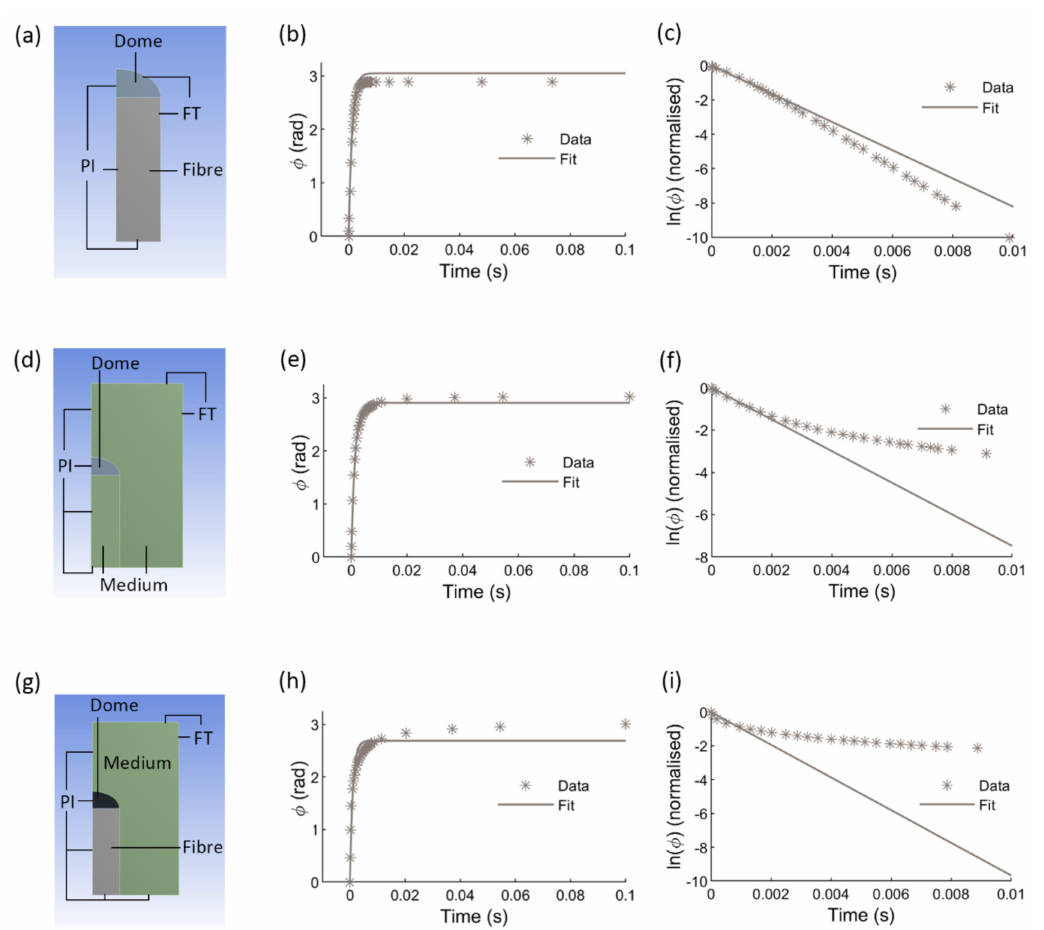
Figure A1. Results of additional temperature step simulations used to investigate the causes of the discrepancy between the simulated sensor data and first order instrument behaviour. These simulations were two-dimensional and axisymmetric, to reduce computation time; in all three models, perfectly insulating boundary conditions (denoted PI) were applied to the edge of the computational domain lying along the axis of symmetry and the lower edge of the computational domain; fixed temperature boundary conditions (denoted FT) were applied to the other edges of the computational domain. ( a ) Geometry for model of fibre and dome with no surrounding medium; ( b ) simulated sensor signal versus time, and fitted curve of the form of Equation (8), for model of fibre and dome with no medium; ( c ) natural logarithm of simulated data and fit shown in ( b ), versus time; ( d ) geometry for model of dome surrounded by medium with no fibre present; ( e ) simulated sensor signal and fitted curve for model with no fibre present; ( f ) natural logarithm of data and fitted curve shown in ( e ) versus time; ( g ) geometry for model with high thermal conductivity of the dome (1000 Wm − 1 K − 1 ); ( h ) simulated sensor signal and fitted curve for model with the highly thermally conducting dome; ( i ) natural logarithm of the simulated data and fitted curve shown in ( h ), versus